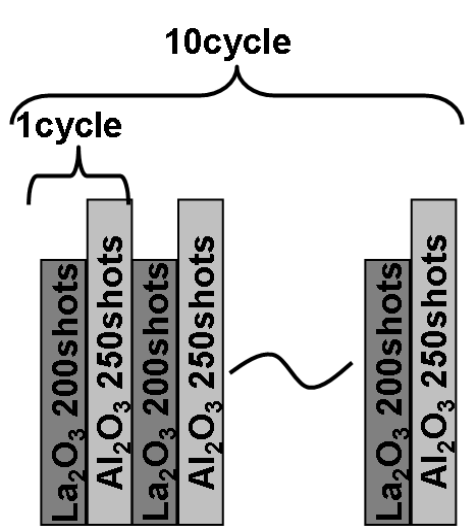
Figure 29. Laser irradiation